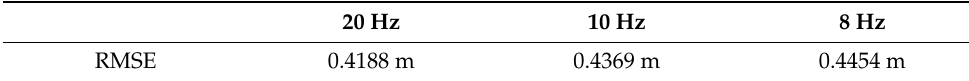
Table 4. The tracking performance with different sampling frequencies.